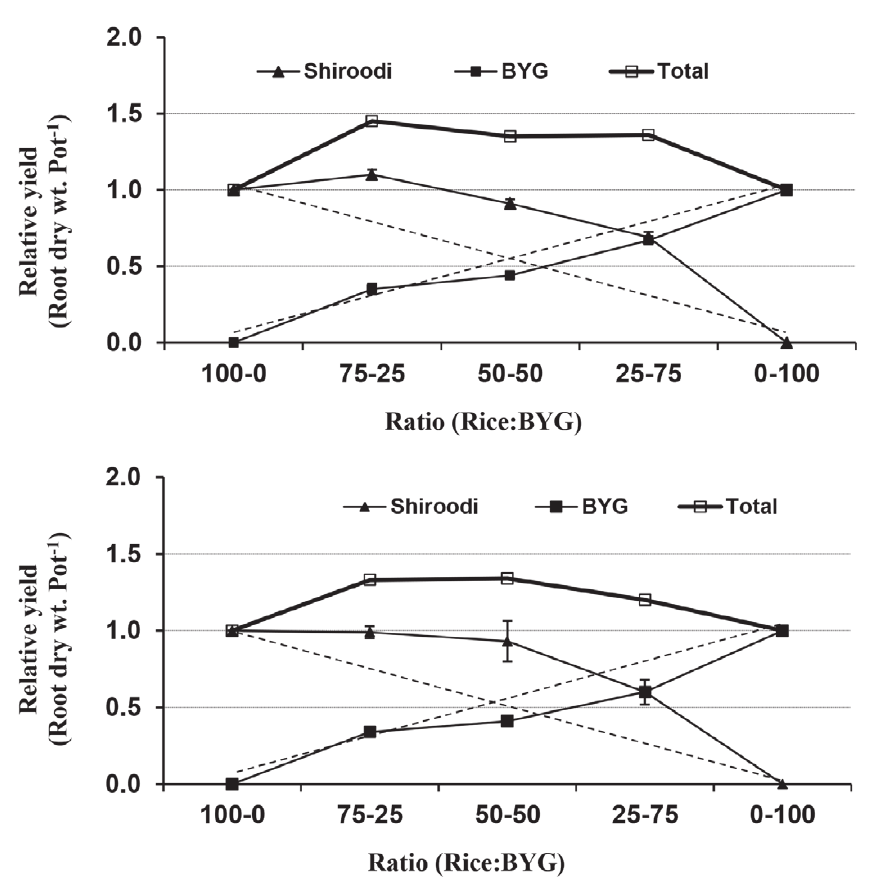
Figure 5 - Relative root dry weights of rice ‘cv. Shiroudi’ (▲), barnyardgrass (BYG) (●) and relative yield totals (RYT) (□) as influenced by methanol foliar application [above: methanol was not sprayed, and below: methanol was sprayed at 14% (v/v)] and rice:BYG ratios in a replacement series over two years. The two straight dashed lines in each frame indicate the theoretically expected responses for two equally competitive species, which intersect at the point of equivalency (Harper 1977). Error bars represent ± standard errors of the mean.